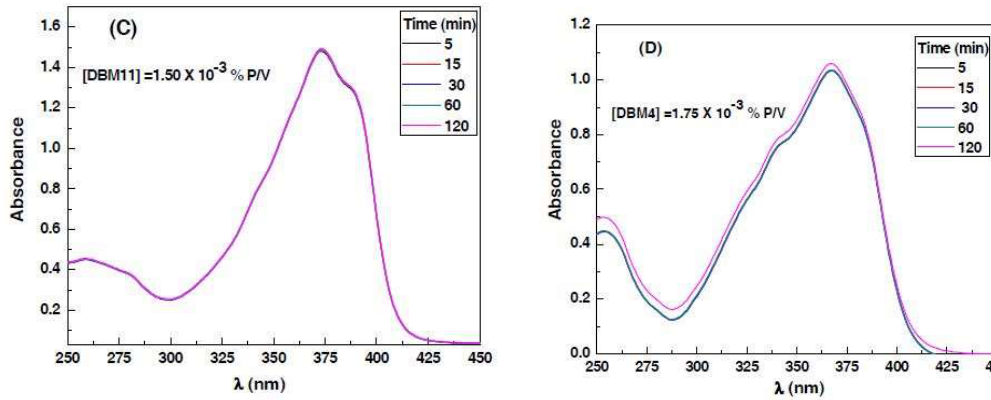
Figure 7. Photodecomposition of dibenzoylmethanes: ( A ) DBM1; ( B ) DBM2; ( C ) DBM11; ( D ) DBM4.